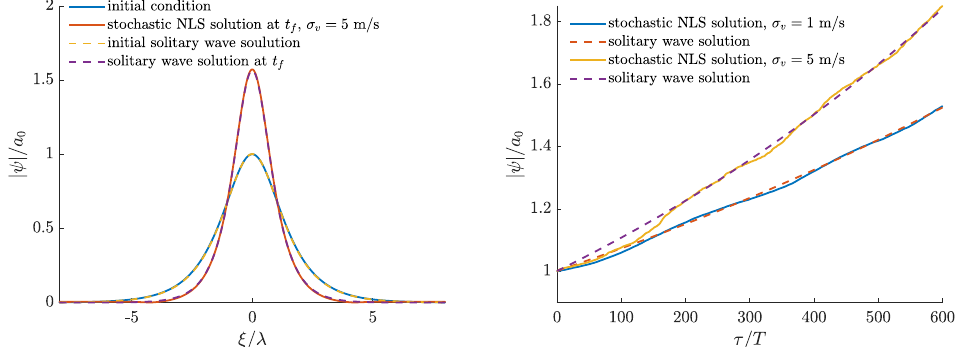
Figure 9. Comparison of the solitary wave solutions from Equation (7) of the NLS (5) with constant forcing and the solutions of the stochastic NLS with σ v = 1 m/s and σ v = 5 m/s. Solutions at initial and final time in space (left) and solutions with respect to time at ξ = 0 (right).